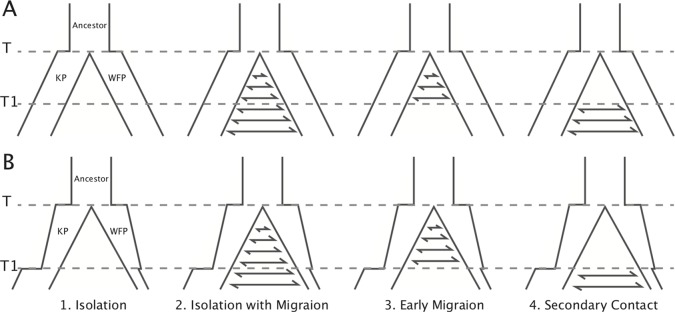
Illustration of the models simulated in ABC analysis. Eight models in two groups were simulated. Effective population sizes in group (A) were constant. Effective population sizes in group (B) were based on N
e changes in PSMC. The PSMC results suggest that the divergence time did not occur earlier than the beginning of the population declines 1 million years ago. To simplify the models, population size shifts and changes of gene flow were set to the same time point (T1). Prior ranges are available in
Supplementary Table 17
.